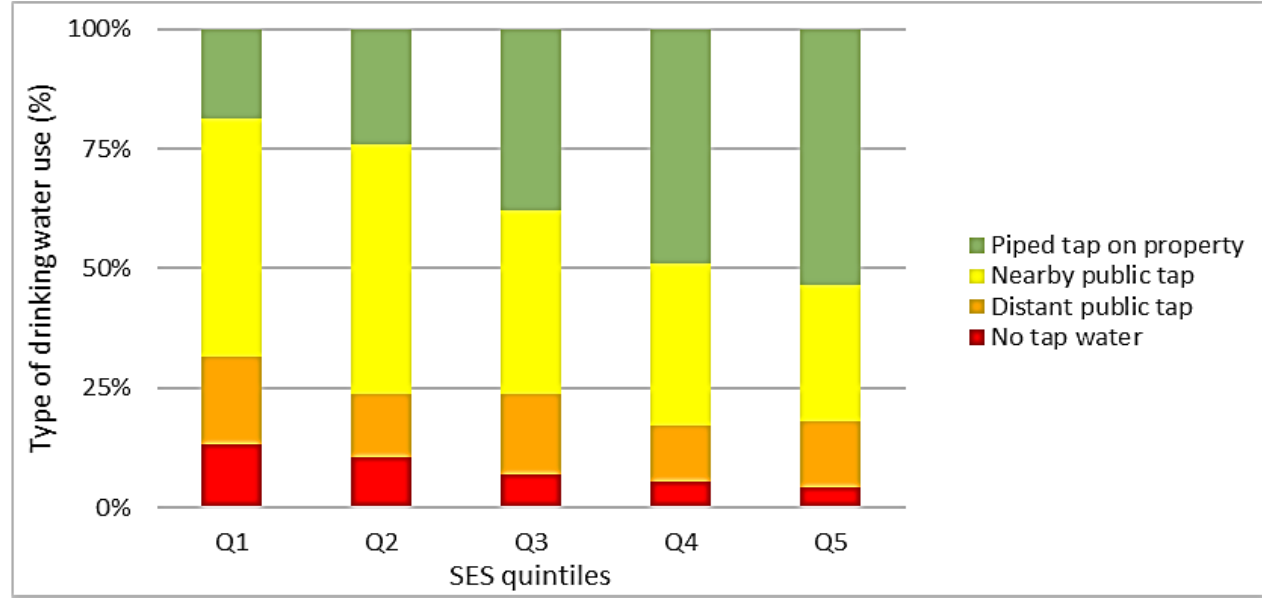
Figure 2. Type of drinking water use stratified by socio-economic status (SES) quintiles, in which the first quintile (Q1) includes the households with the lowest SES and the fifth quintile (Q5) the households with the highest SES.